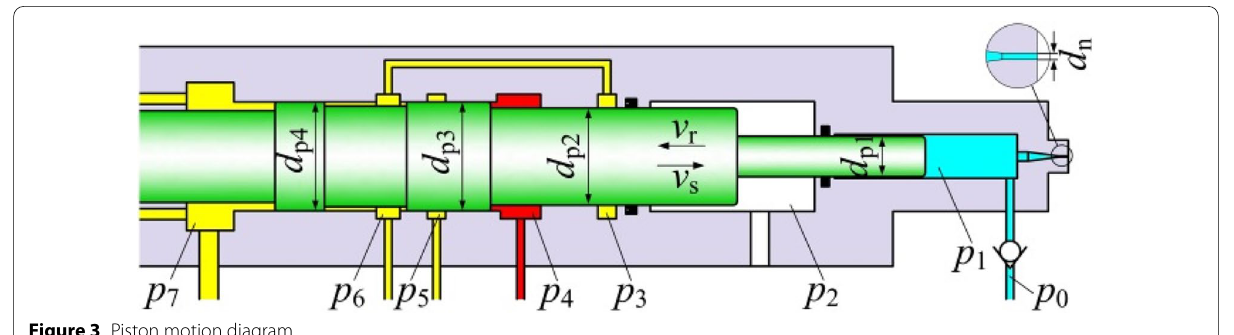
Figure 3 Piston motion